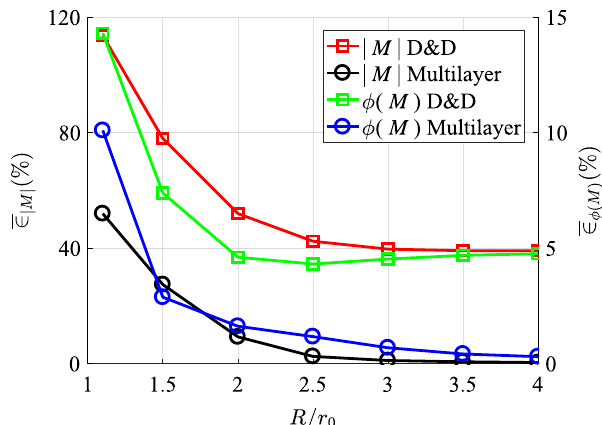
Fig. 4. Average relative errors of the D&D and the multilayer solutions in terms of modulus and phase of the mutual inductance with respect to CST simulation results for several different sizes of the